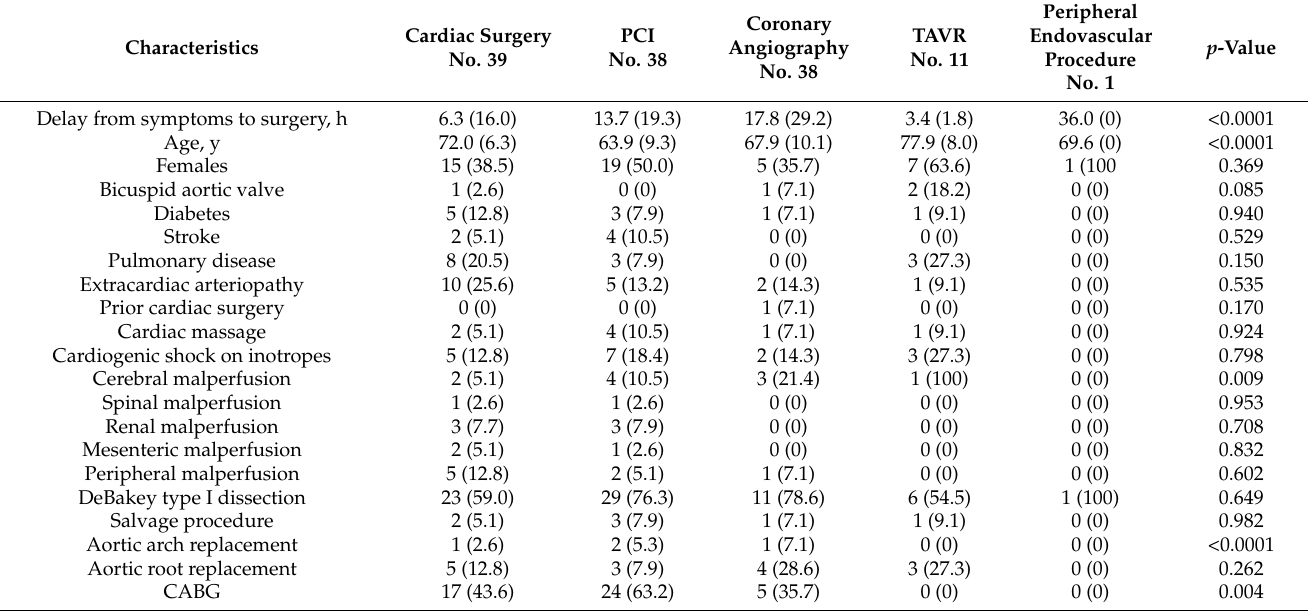
Table 2. Characteristics and operative data of patients with iatrogenic acute TAAD according to the main causes of aortic